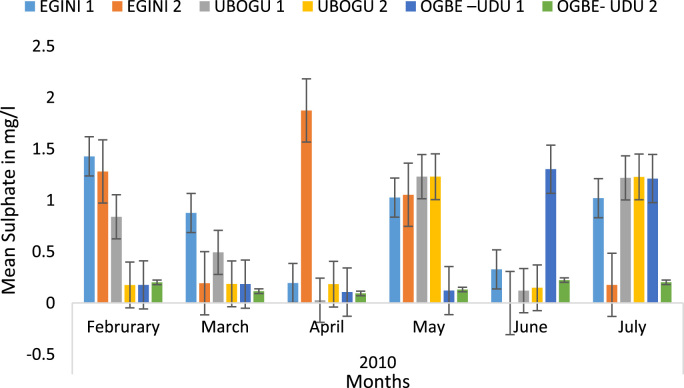
Mean Temporal and spatial variations in sulphate.